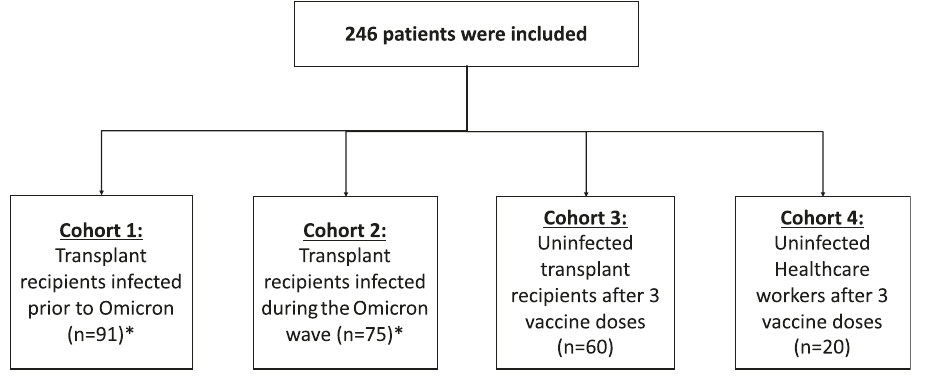
Fig.1|Flowdiagramofthestudy. Atotalof246participantswereincludedinthe study. Cohort 1 ( n =91) consisted of transplant recipients infected with ancestral SARS-CoV-2 ( n =71), Alpha ( n =17), Delta ( n =2), or unknown ( n =1). Cohort